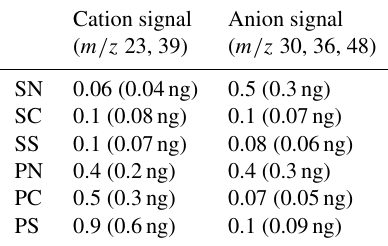
Table 3. Limit of detection (LOD; µgm − 3 ) for the mass concen- trations of SN, SC, SS, PN, PC, and PS particles. The values in parentheses denote the mass loadings